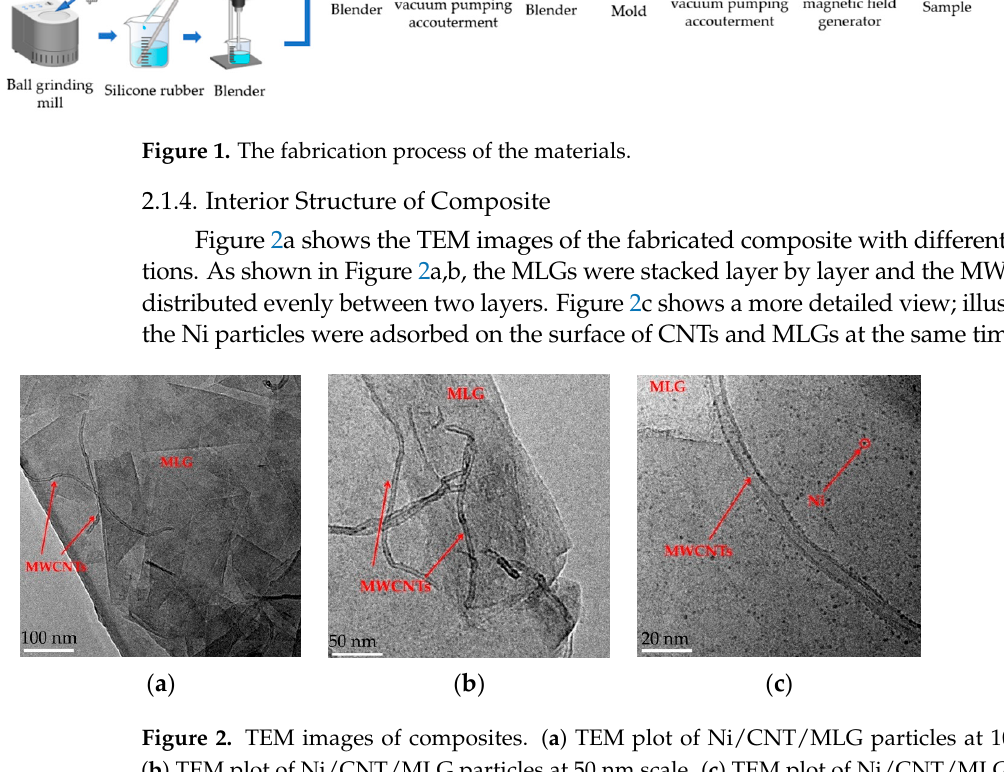
Figure 1. The fabrication process of the materials.